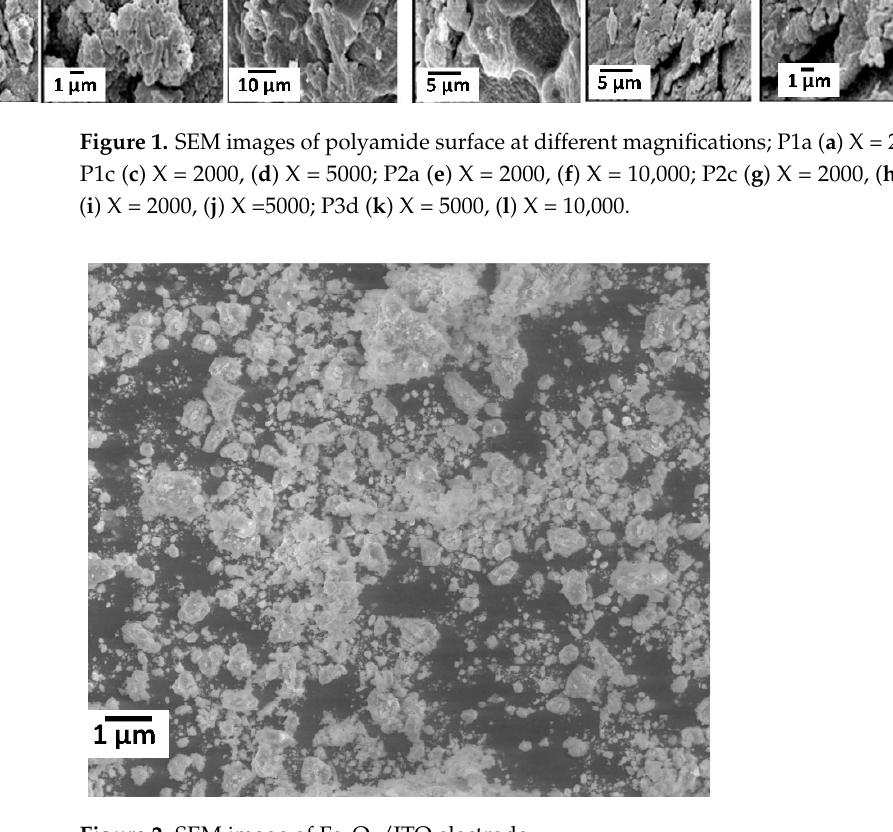
Figure 3. UV-vis absorption spectra of ( a ) P1a–d, ( b ) P2a–d, ( c ) P3a,b,d, and ( d ) P4c,d. 3.3.5. TGA Studies The thermal behavior of all synthesized polyamides, P1a–d, P2a–d, P3a,b,d, and P4c,d, was evaluated by TGA under a nitrogen atmosphere at a heating rate of 10 °C/min (see Supporting Information). The temperature values, corresponding to 10%, 20%, 30%, 40%, and 50% weight loss in addition to char yield and LOI (limiting oxygen index) at 800